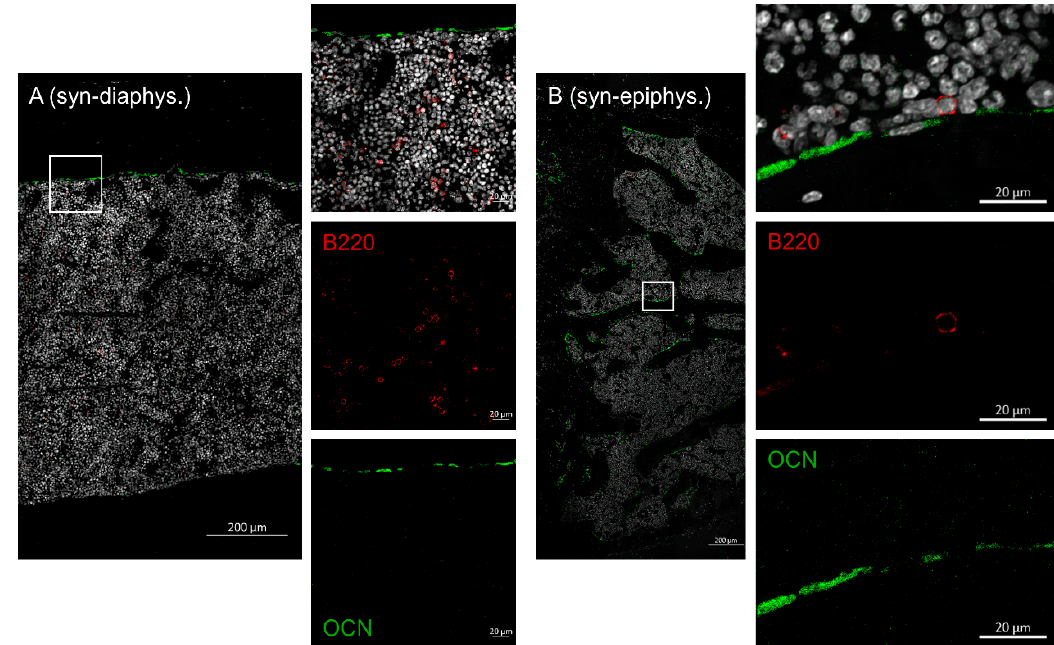
Figure 4. Femora harvested at day +20 after syn-HSCT were prepared for immunohistochemistry (N = 6). Within the diaphysis of the femora ( A syn-diaphys.) osteoblasts line the endosteal region while B cells are evenly distributed within the marrow cavity, the same result was true for the epiphyseal bone ( B syn-epiphys.). Nuclei (Dapi = white, 2nd outtake image from top to bottom), B cells (B220 = red, single stain 3rd outtake image from top to bottom), osteoblasts (osteocalcin = green, single stain 4th outtake image from top to bottom). Representative images are shown.